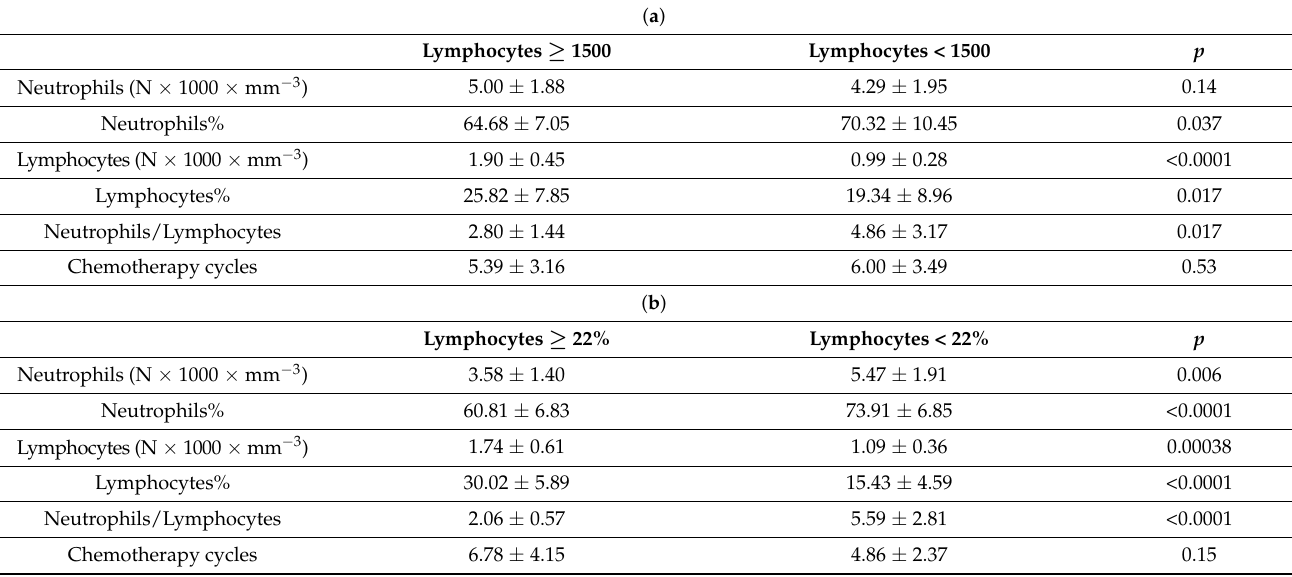
Table 3. Values of Neutrophils (absolute and percentage), lymphocytes (absolute and percentage), neutrophils lymphocytes ratio and number of chemotherapy cycles. ( a ) Lymphocytes ≥ or < 1500 (absolute value); ( b ) lymphocytes ≥ or < 22% (percentage value); ( c ) lymphocytes ≥ or < 29.7% (percentage value); ( d ) response to first-line chemotherapy: PR partial response; SD stable disease; DP disease progression. Data are reported as mean ± SD. ( a